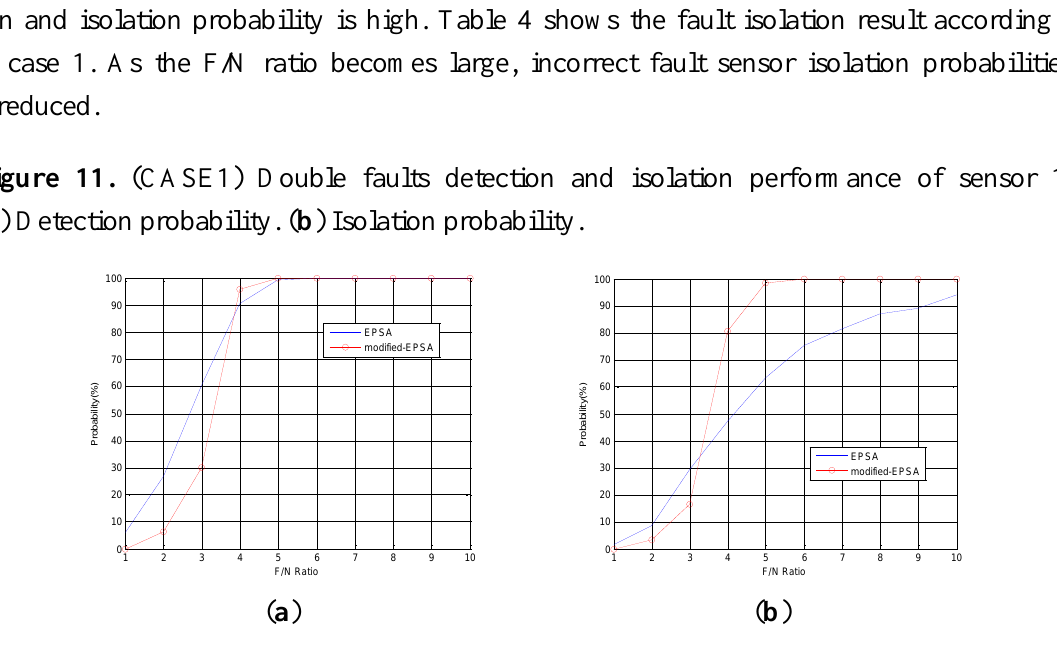
Figure 12. (CASE1) Double faults detection and isolation performance of sensor 1 and 4.